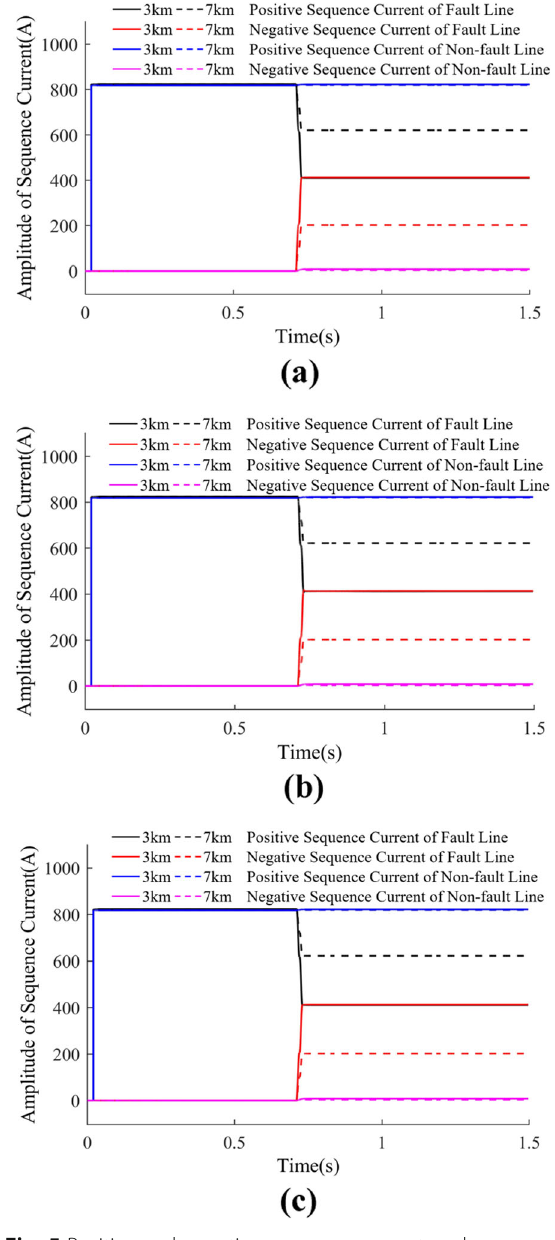
Fig. 5 Positive and negative sequence current under different grounding modes (a) Ungrounded (b) Arc suppression coil grounded (c) Low resistance